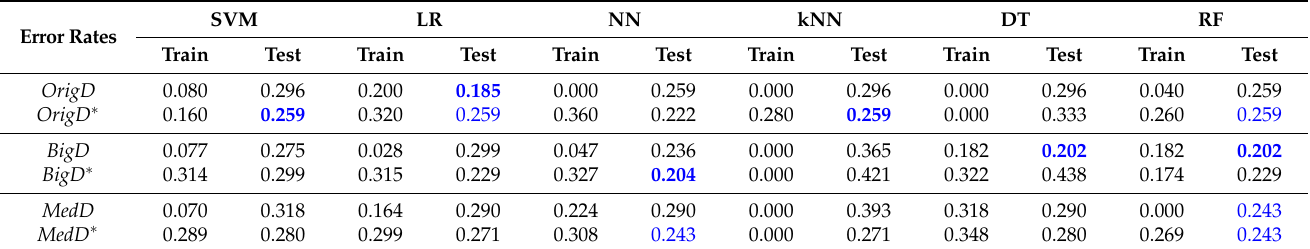
Table 8. Error rates for all datasets when fine-tuning meta-parameters.